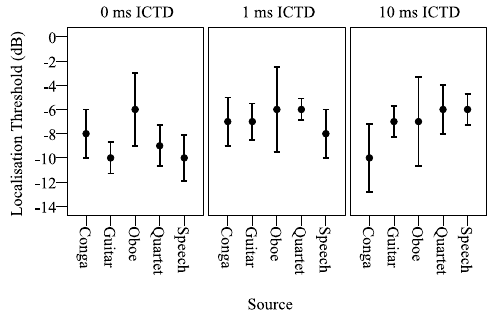
Figure 6. Medians and associated notch edges with the results for both presentation methods combined, arranged to compare the localisation thresholds for each sound source at each ICTD.